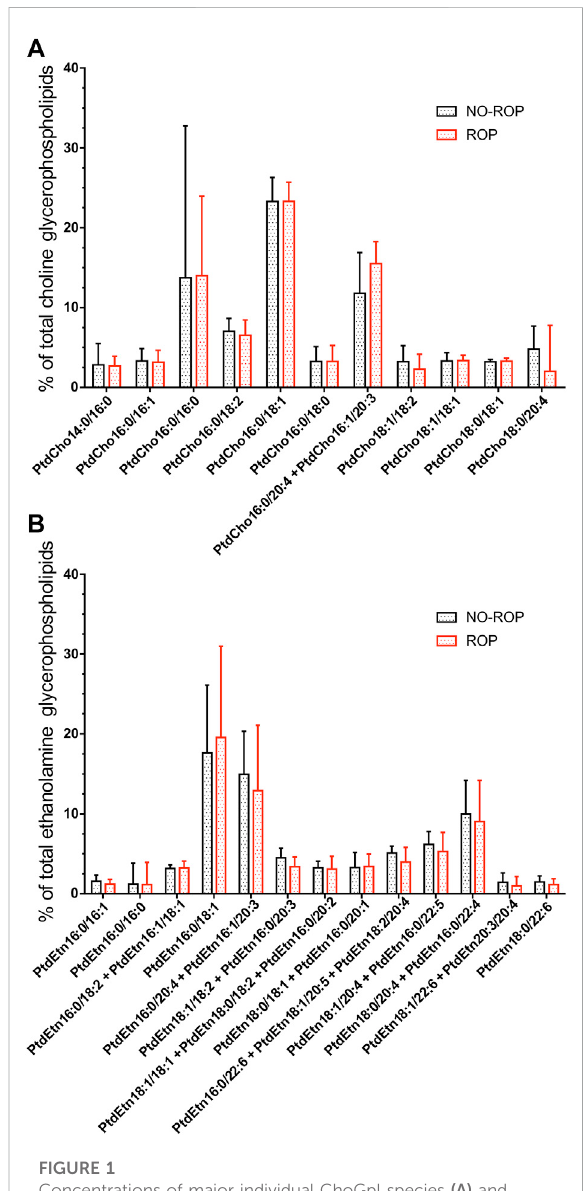
FIGURE 1 Concentrations of major individual ChoGpl species (A) and major EtnGpl species (B) of red blood cells of preterm infants without or with retinopathy of prematurity (% of total ChoGpl or % of total EtnGpl). No signi fi cant difference was observed between no-ROP and ROPgroupsfor anyspecie. Abbreviations of individual phospholipid species are as follows: Position on the glycerol backbone as shown as sn-1/sn-2 of the fatty alcohol radicals (abbreviated as number of carbons: Number of double bonds). PtdCho: Phosphatidylcholine; PtdEtn: Phosphatidylethanolamine; ROP: Retinopathy of